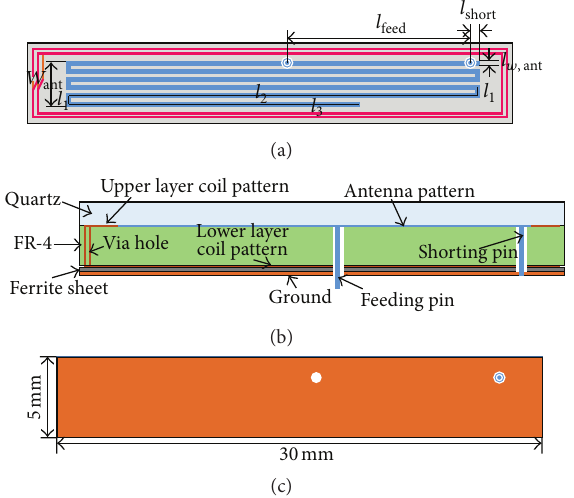
Figure 6: Geometry of the proposed resonant coil and MICS antenna: (a) top, (b) side, and (c) bottom.